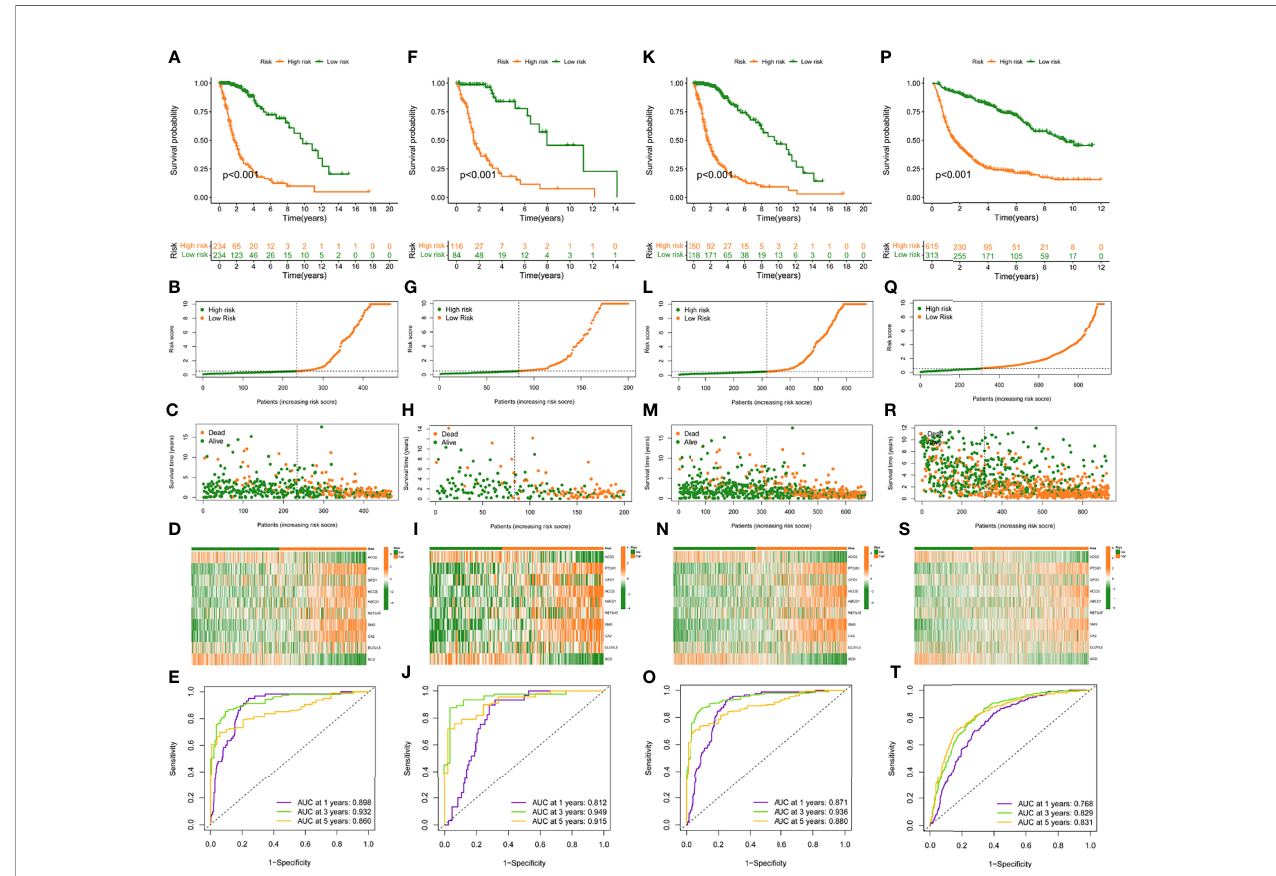
FIGURE 3 | Construction and validation of risk model in TCGA training, testing, entire cohort, and CGGA cohort. (A, F, K, P) , (K – M) curves of subgroups for OS in TCGA training, testing, entire cohort, and CGGA cohort. The distribution plots of risk score (B , G , L , Q) , survival status (C , H , M , R) , and 10 selected FAMDs (D , I , N , S) in TCGA training, testing, entire cohort, and CGGA cohort. (E , J , O , T) ROC curve analysis of risk score in predicting 1-, 3-, and 5-year OS in TCGA training, testing, entire cohort, and CGGA